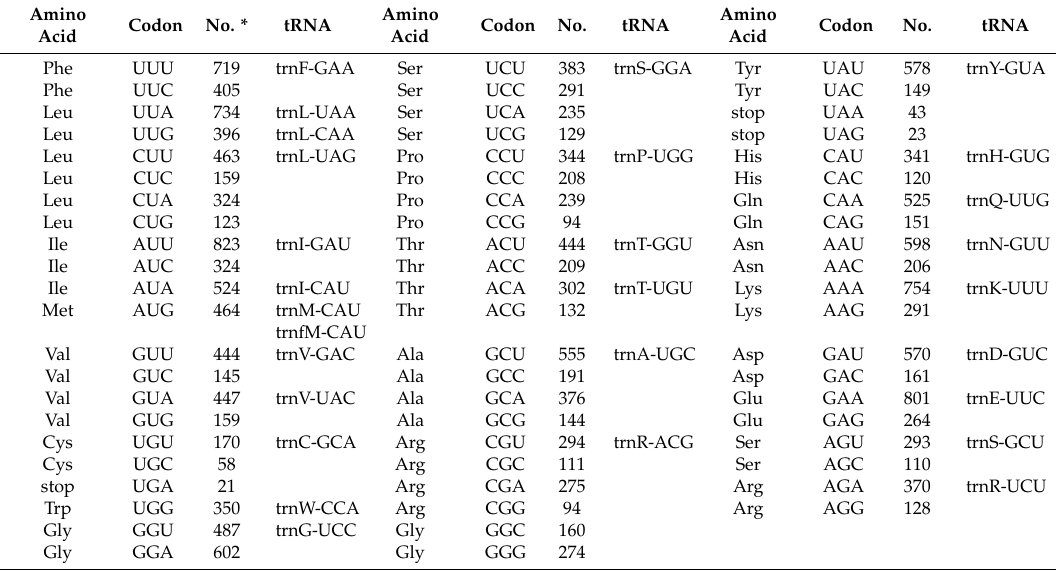
* Numerals indicate the frequency of usage of each codon in 20,301 codons in 78 potential protein-coding